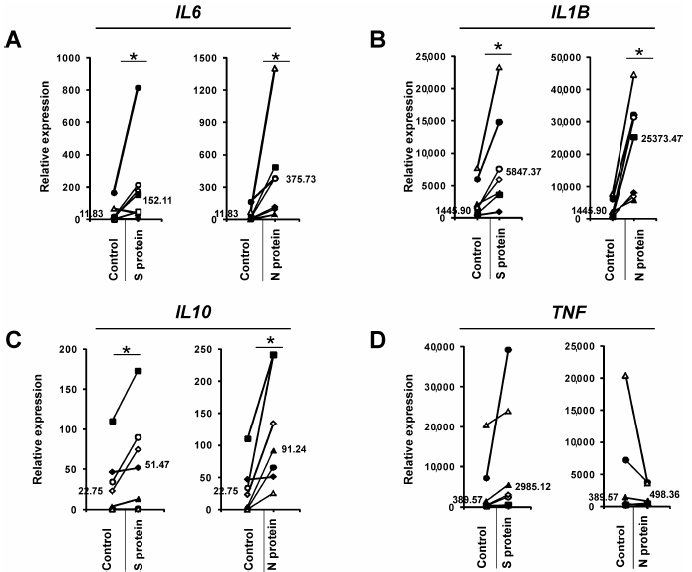
Figure 3. mRNA expression of IL6 ( A ), IL1B ( B ), IL10 ( C ), and TNF (D) genes in monocytes differentiated towards macrophages in the presence of 1 μg /mL SARS-CoV-2 proteins S (spike) and N (nucleocapsid) for 5 days. Control cells were treated with an equal volume of PBS. The expression of each mRNA was determined by real-time RT-PCR and normalized to the mRNA levels of the housekeeping genes HPRT1 , HMBS , and RPL13A , as described in the Materials and Methods section. The data show individual values for seven independent donors ( n = 7), and straight lines connect the control value and the value after SARS-CoV-2 protein treatment from individual donors. The median values are also shown in the figures. An asterisk indicates a statistically significant difference at p < 0.05.